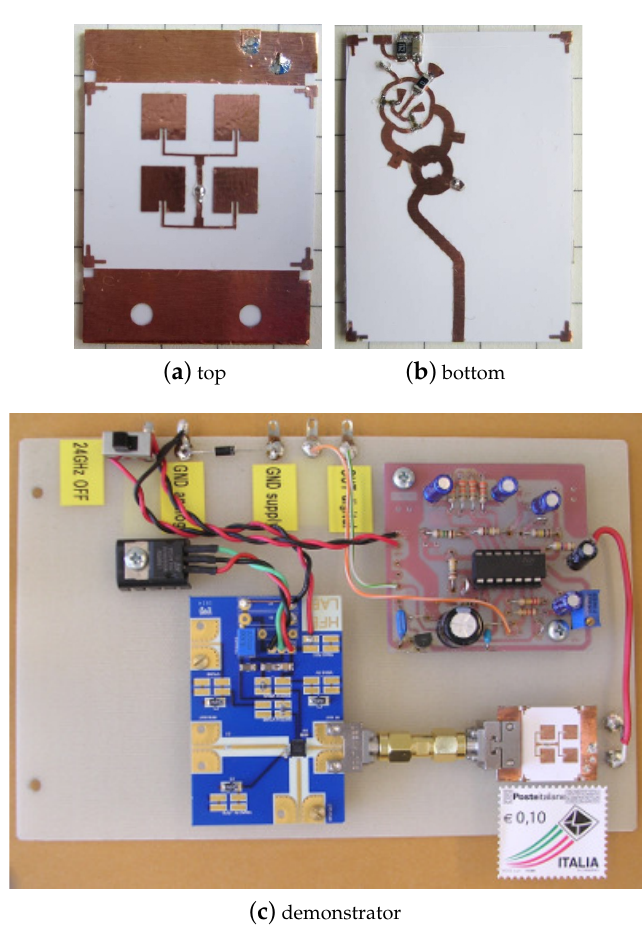
Figure 4. Fabricated 24-GHz front-end on a multi-layer cellulose-based substrate. ( a ) Antenna side. ( b ) Active circuit side. ( c ) Demonstrator including external VCO, intermediate frequency (IF) amplification and triggering stages. The used substrate area is 20 × 27mm 2 . The realized cellulose circuit has the size of a postage